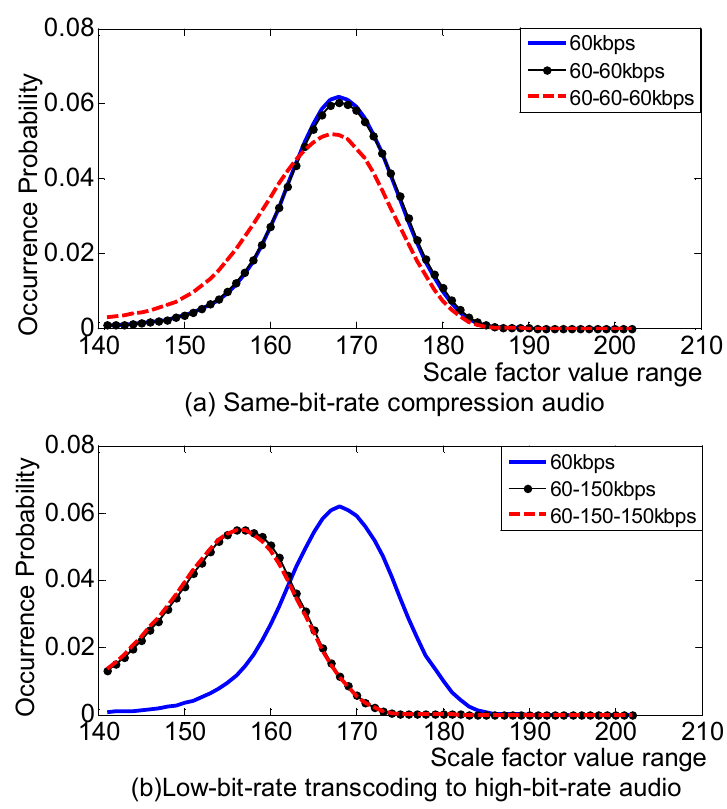
Figure 2. AAC audio scale factor occurrence probability.